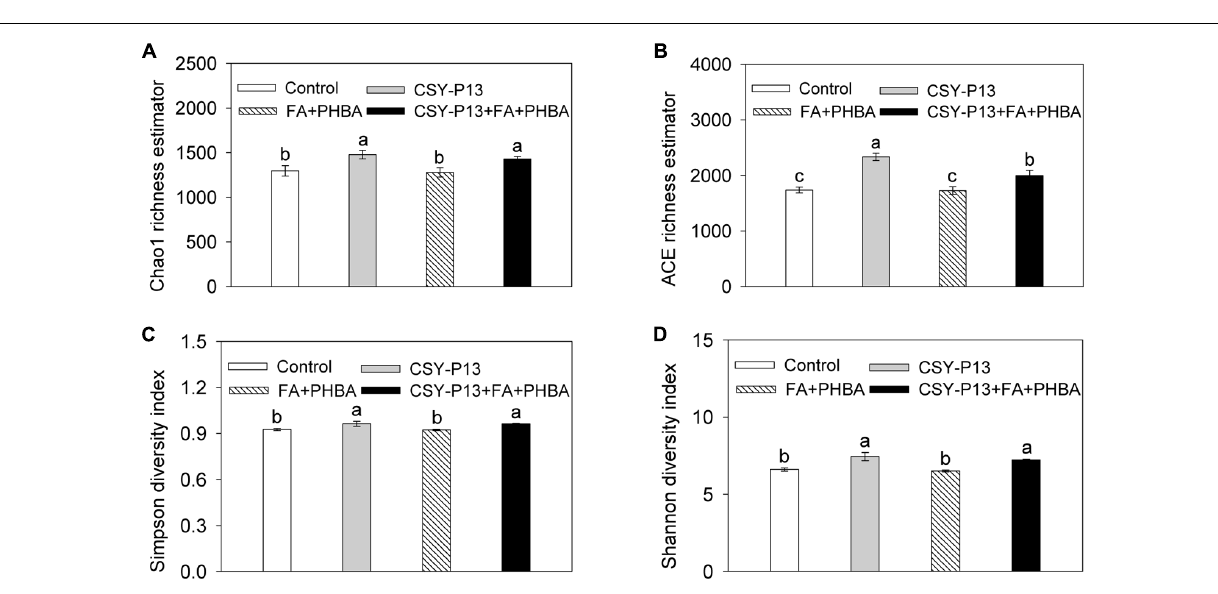
FIGURE 8 | Effects of CSY-P13 and the mixture of FA and PHBA on bacterial richness and diversity in cucumber rhizospheric soil by the Chao1 (A) and ACE (B) richness estimators and the Simpson (C) and Shannon (D) indices. Bars represent standard errors of three biological replicates. Values with the different letters are significantly different at P < 0.05 by LSD test using SPSS for Windows 22.0 software (IBM Corp., Armonk, NY, United